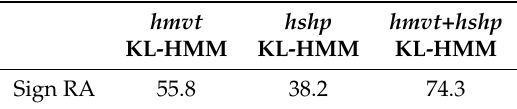
Table 9. Sign RA on the DSGS database of the KL-HMM system depending on the movement ( hmvt ) DSGS subunits posterior probabilities, the hand shape ( hshp ) features or both ( hmvt+hshp ) of them.